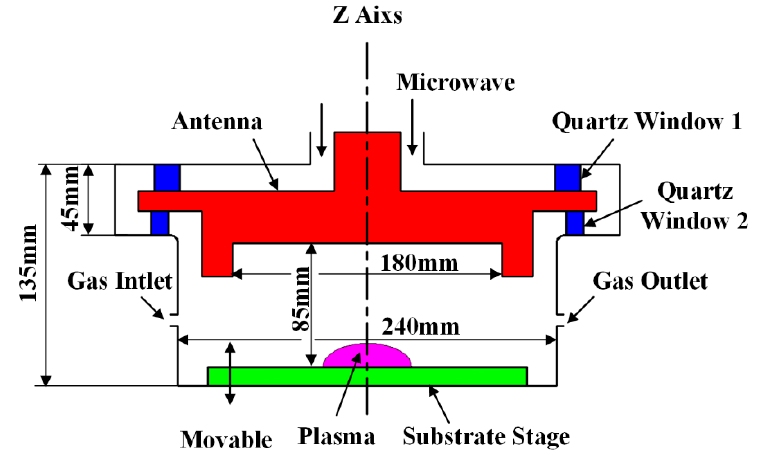
Figure 1. Schematic cross-section view of newly designed cylindrical cavity.